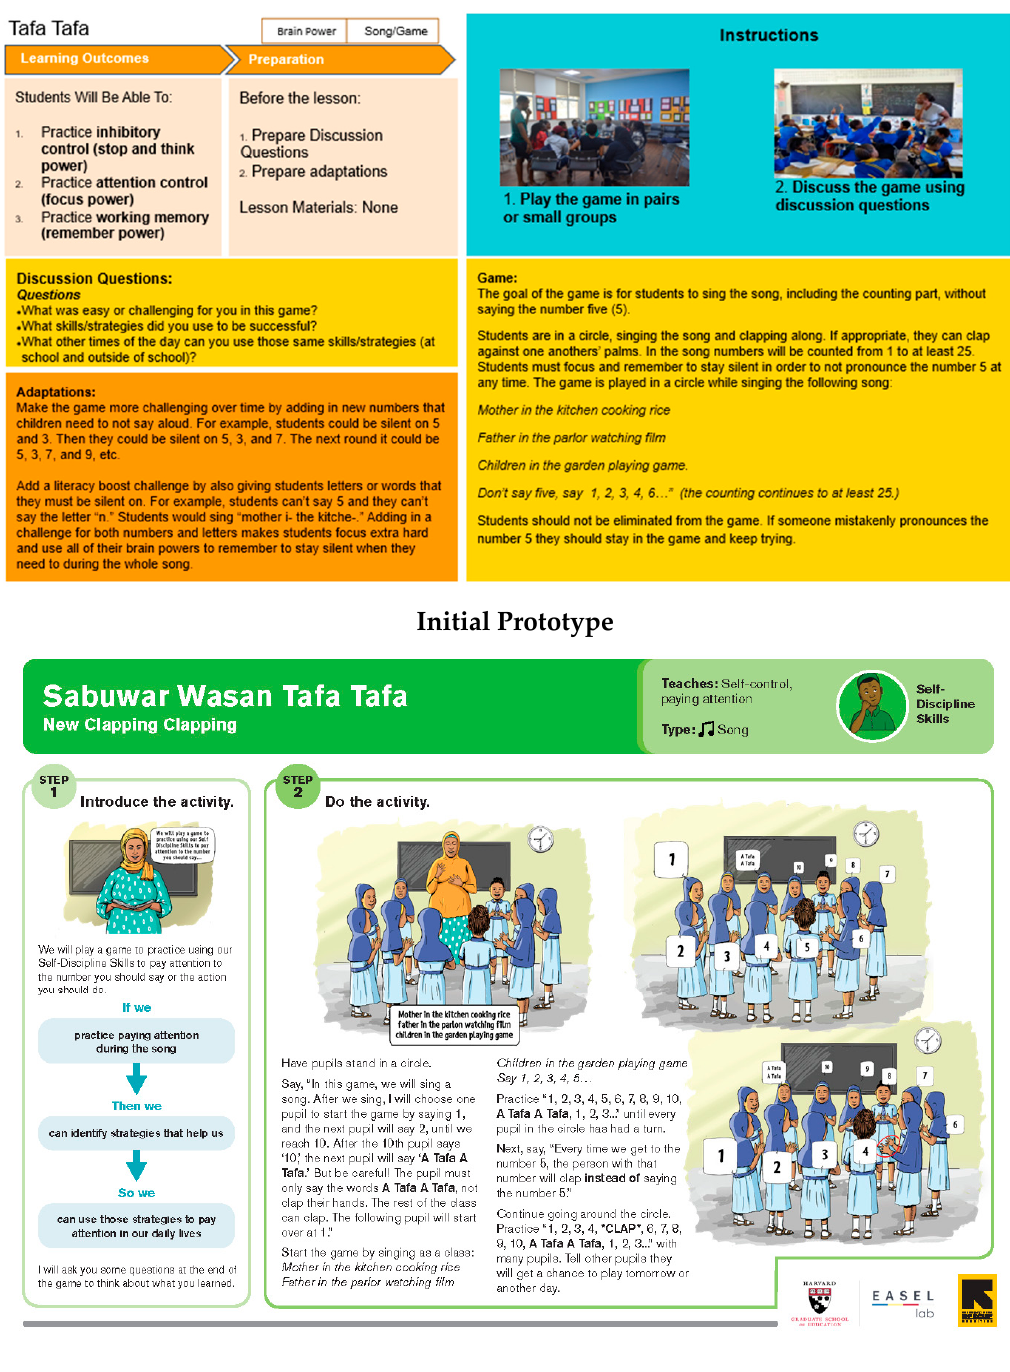
Figure 1. Initial and revised prototypes.